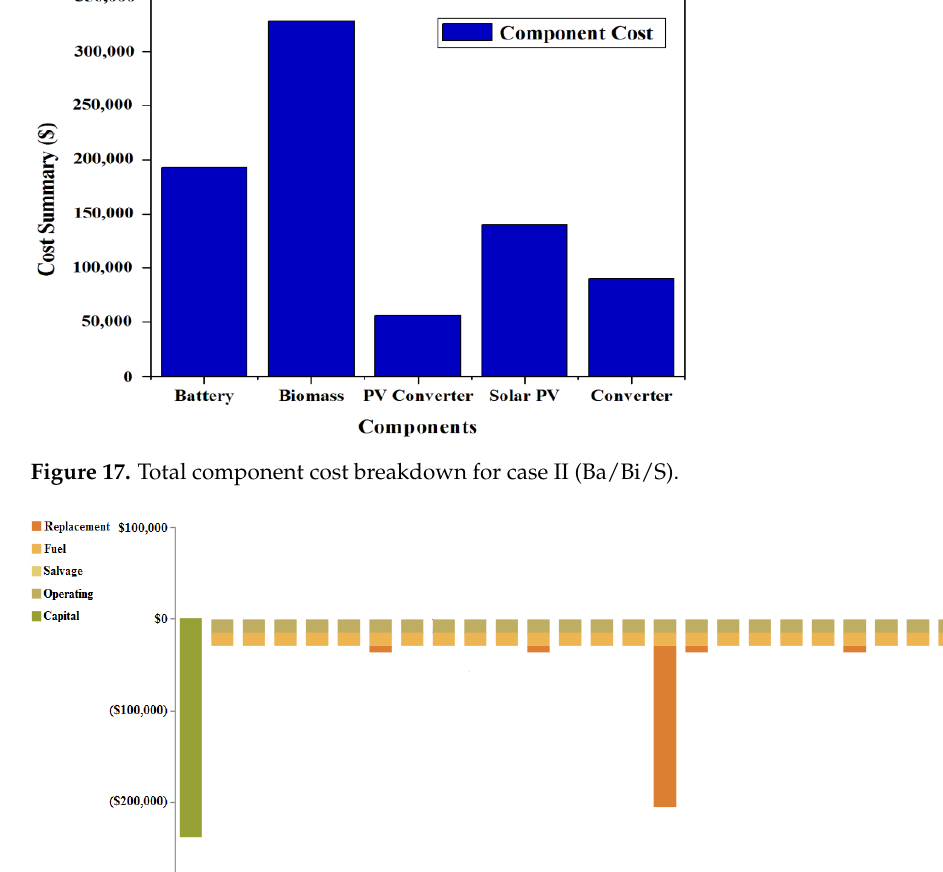
Figure 19. Renewable energy generation percentage for case III (Ba/H/S).